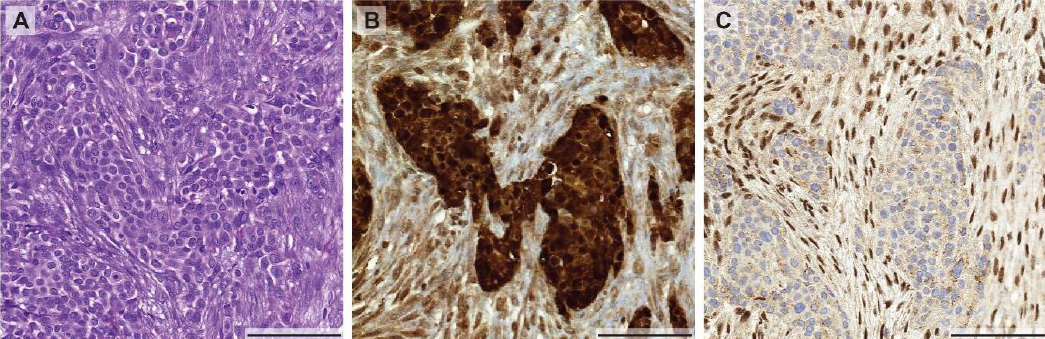
Figure 1. Morphological and immunohistochemical heterogeneity in mesothelioma. ( A ) Biphasic mesothelioma consisting of an epithelioid and sarcomatoid component (H&E stain), highlighted by a calretinin staining ( B ) showing a weaker expression in the sarcomatoid proliferation. ( C ) Heterogeneous expression of BAP-1 with positive nuclear staining in the sarcomatoid component and loss of BAP-1 expression in the epithelioid areas of the tumor. All pictures were taken at 10× magnification (scale bar: 100 µm).